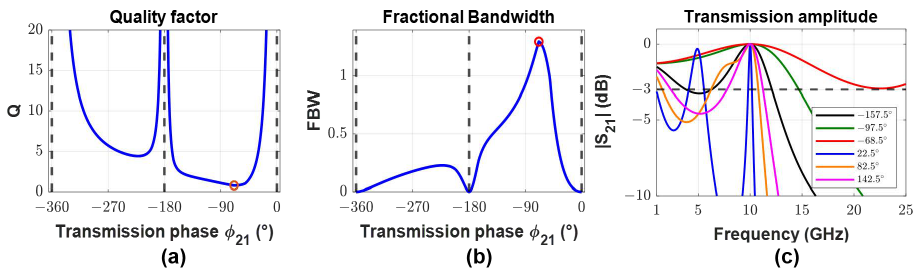
Figure 5. The quality factor, fractional bandwidth, and the magnitude of the frequency response for metasurfaces that provide impedance matching with six different transmission phases. ( a ) The quality factor is minimized when the transmission phase is − 68.5 ◦ (red circle). ( b ) The fractional bandwidth is maximized at − 68.5 ◦ (red circle). ( c ) Plots of the transmission amplitude over frequency for several transmission phases and the maximum bandwidth is observed when the transmission phase is − 68.5 ◦ , as predicted by the quality